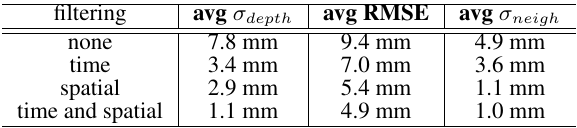
Table 3. Performance comparison using time and spatial filtering filtering